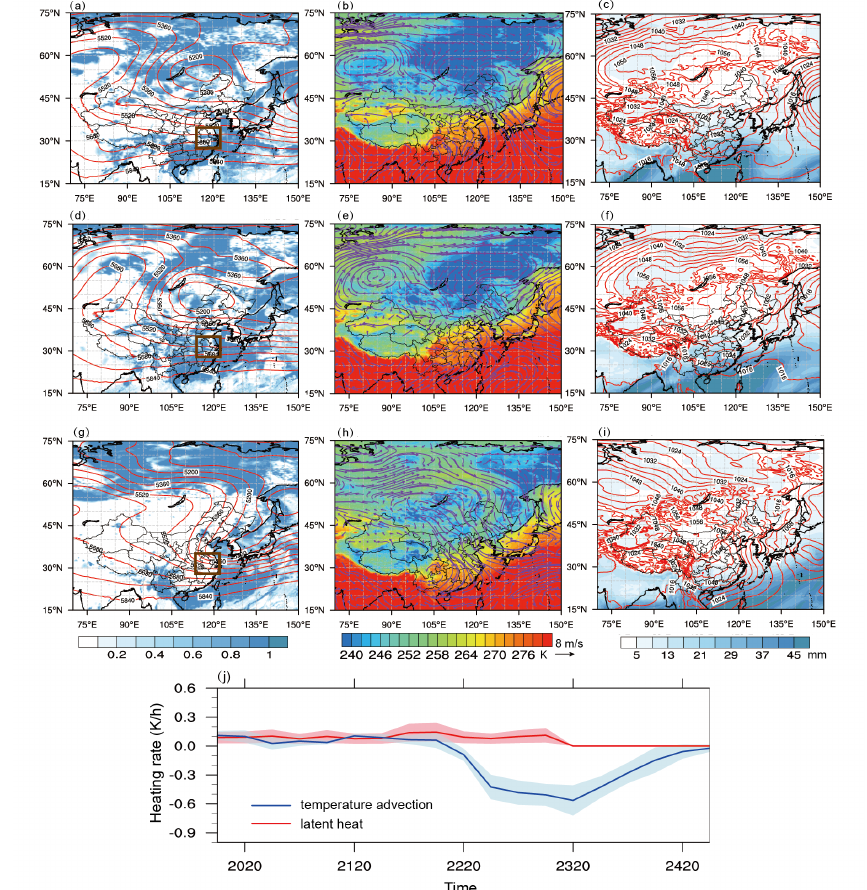
Figure 8. Synoptic analysis of a cold wave case in late winter: ( a ) Cloud cover and 500hPa geopotential height, ( b ) 2m temperature and 850hPa winds, and ( c ) total precipitable water and SLP at 8 am on 21 January 2016; ( d – f ) that at 8 am on 22 January 2016, respectively; and ( g – i ) that at 2 am on 24 January 2016, respectively. ( j ) The time-series of the mean heating rate caused by 850 hPa temperature advection and latent heat over the brown square in ( a , d , g ).The time is presented by 4 digits, with the first 2 digits indicating the date in January 2016 and the last 2 digits indicating the local